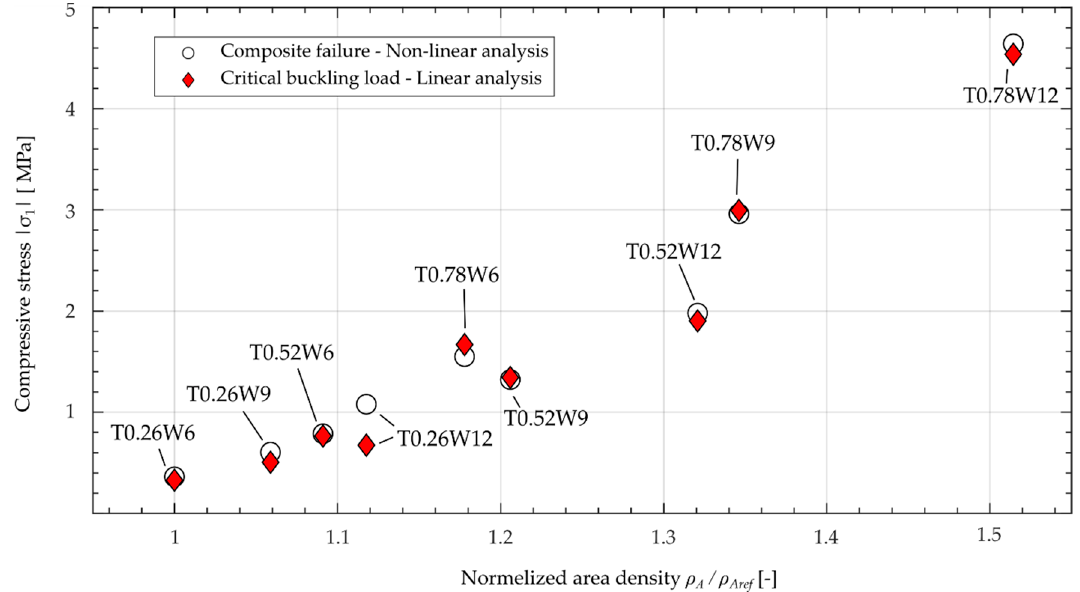
Figure 9. Comparison of calculated composite failure of the nonlinear analysis and the critical buckling load of the linear analysis over the normalized area density.